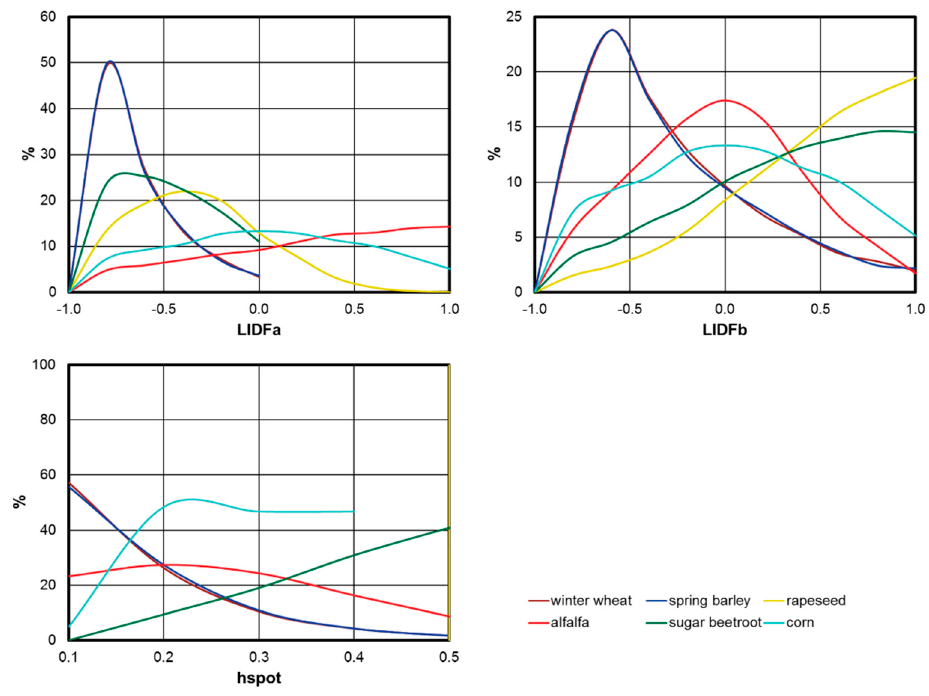
Figure 6. Empirical distribution functions of LIDF a , LIDF b , and Hspot parameters for six crops of interest.